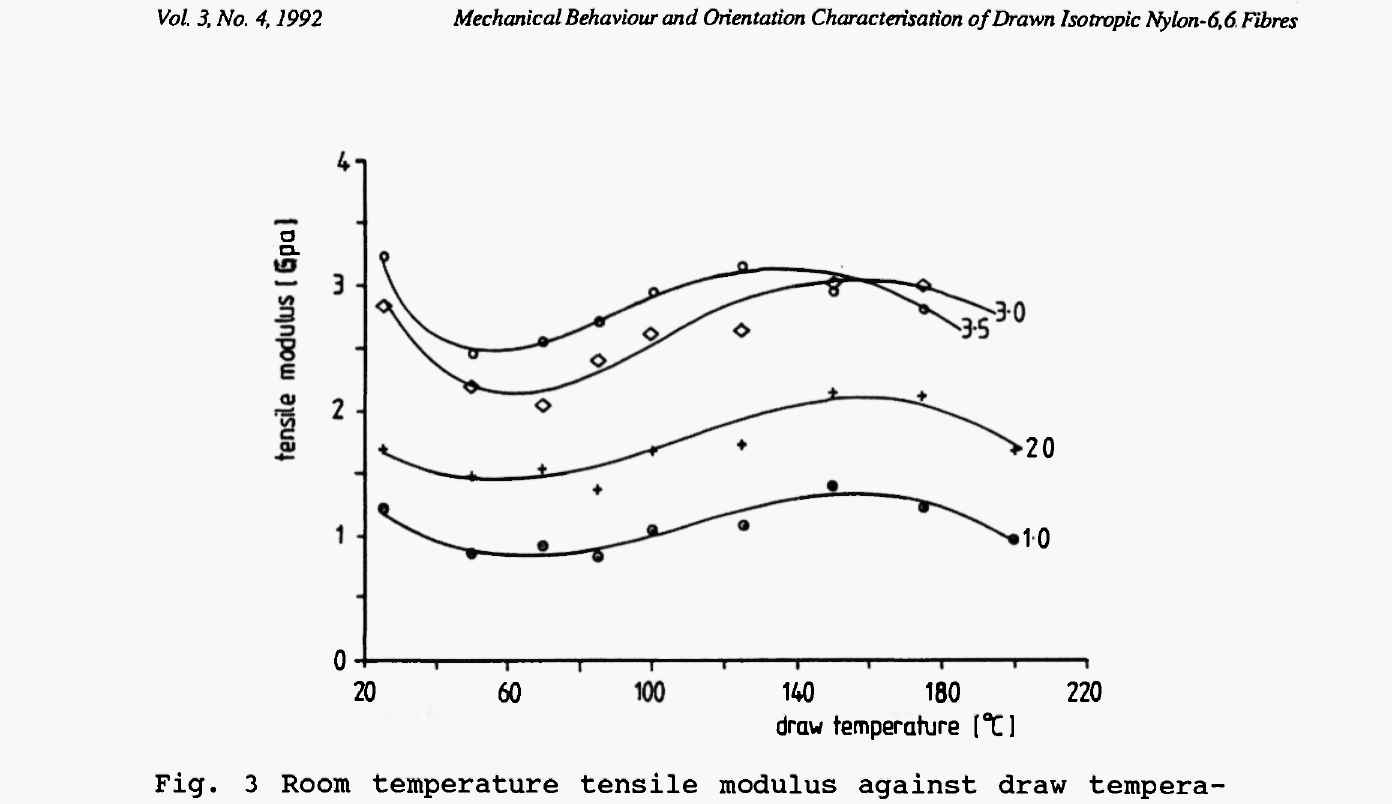
Fig. 3 Room temperature tensile modulus against draw tempera- tures at different draw ratios of 1.0, 2.0, 3.0 and